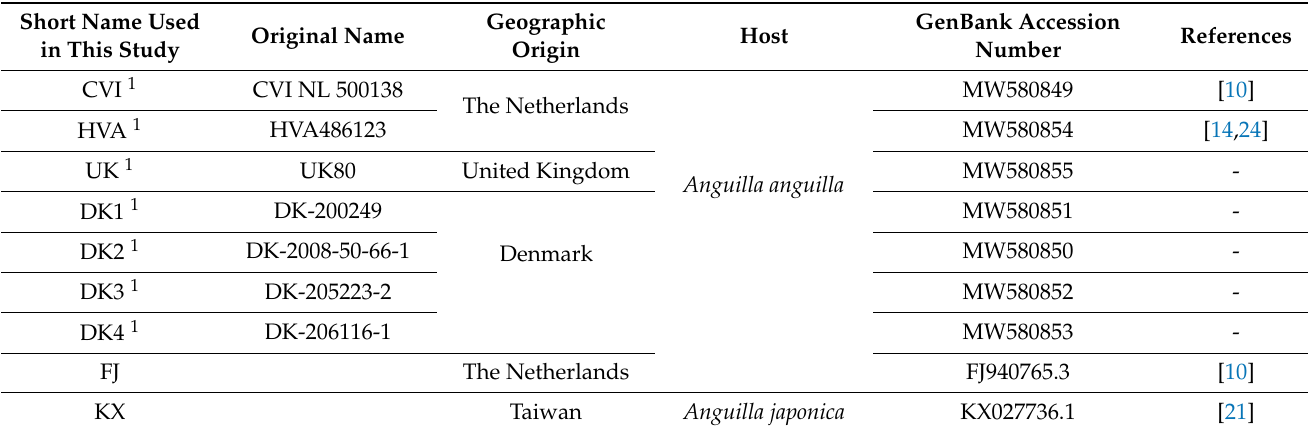
Table 1. List of AngHV-1 strains referred to and used in this